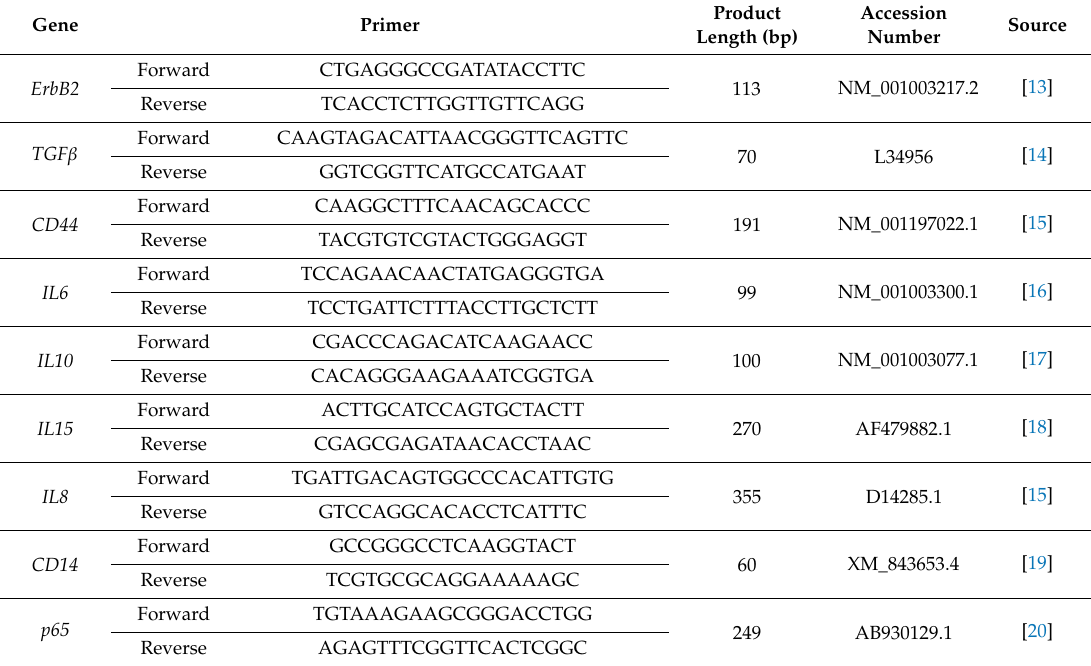
Table 2. Primer Set for Sybrgreen quantitative, real-time (RT)-PCR amplification of canine genes. Gene